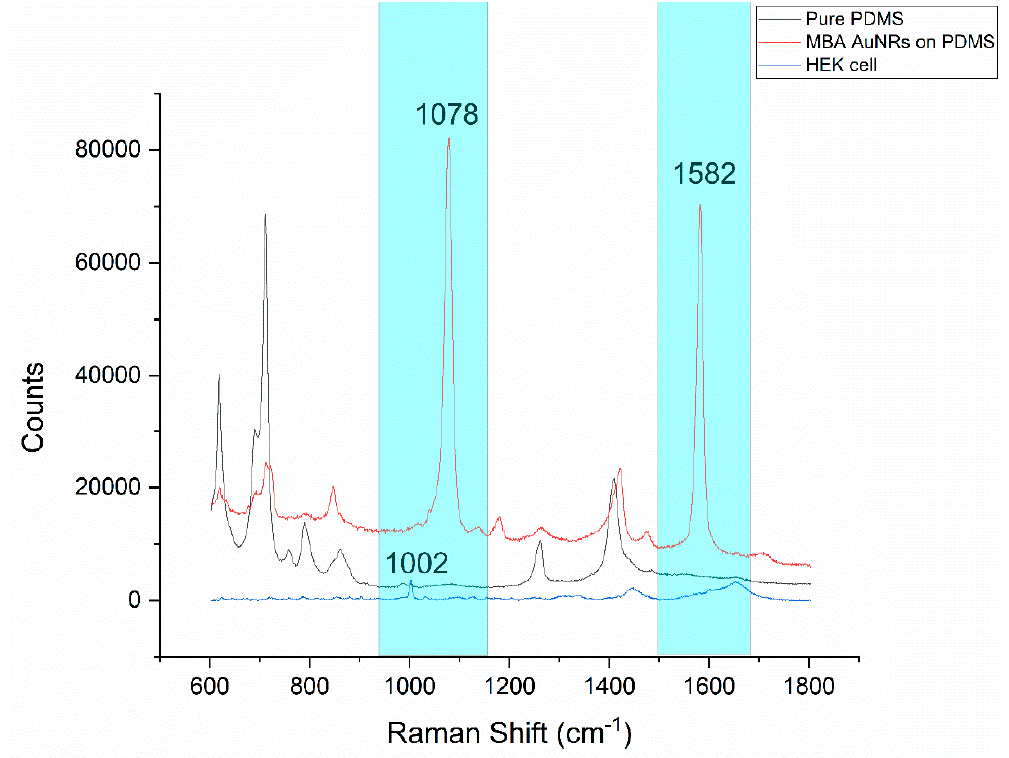
Figure 5. Raman spectra comparison, native HEK293 cell and polydimethylsiloxane (PDMS) with/without the presence of the 4-mercaptobenzoic acid (MBA)-gold nanorods (AuNR-antibody SERS probe. The spectral ranges with the MBA peaks and without the PDMS peaks are highlighted with cyan.